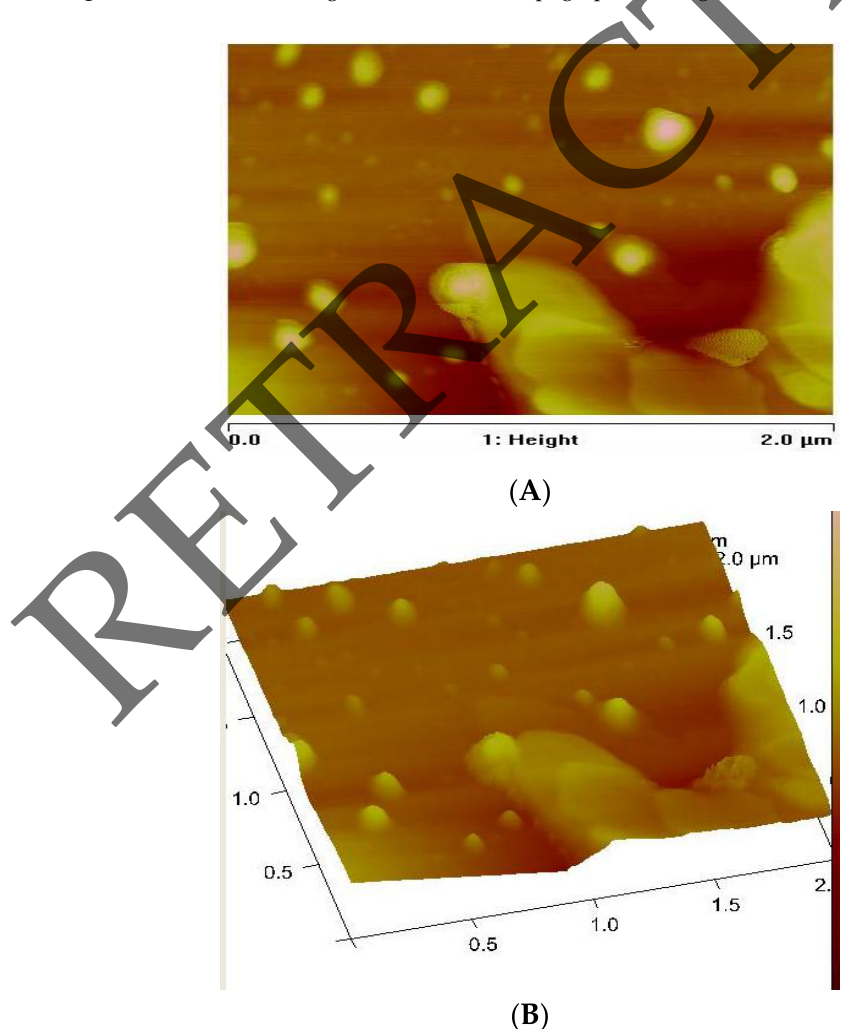
Figure 7. AFM surface roughness ( A ) and 3D topographical images ( B ) of CuS2 nanoparticles.